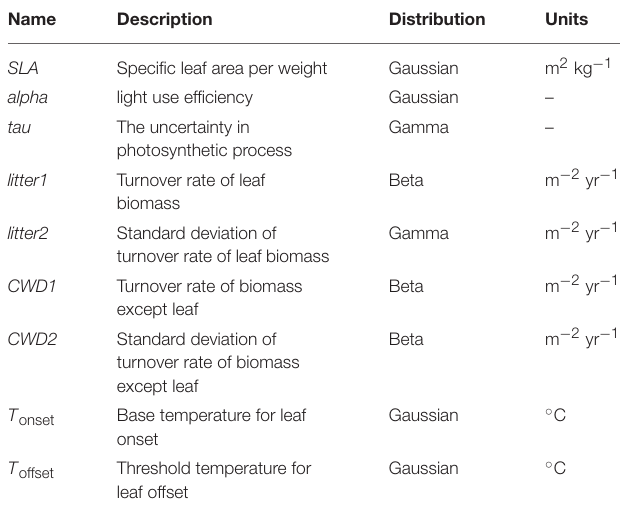
TABLE 1 | List of parameters used in